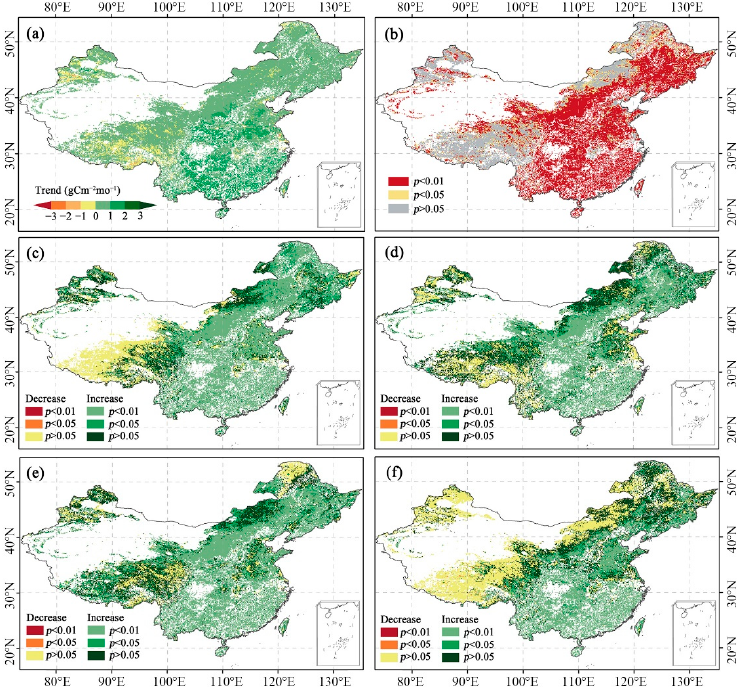
Figure 4. Spatial distribution of annual ( a ) changing trend, ( b ) p -value, and seasonal changing trend in ( c ) spring, ( d ) summer, ( e ) autumn, and ( f ) winter of gross primary productivity (GPP) across China from 2001 to 2020 based on the Mann–Kendall (M–K) trend test.